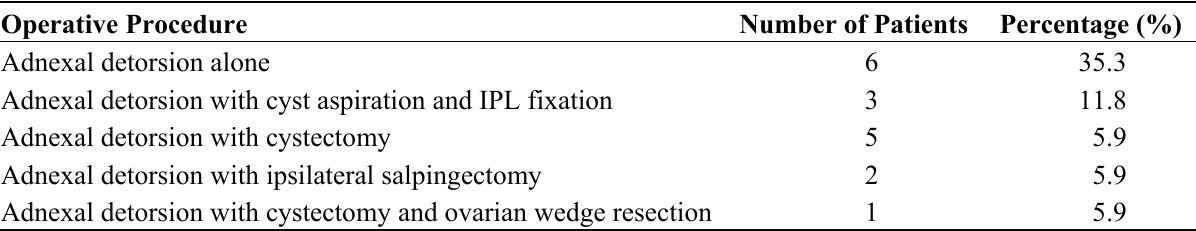
Table 2. Details of the operative procedure in patients with adnexal torsion during pregnancy. Operative Procedure